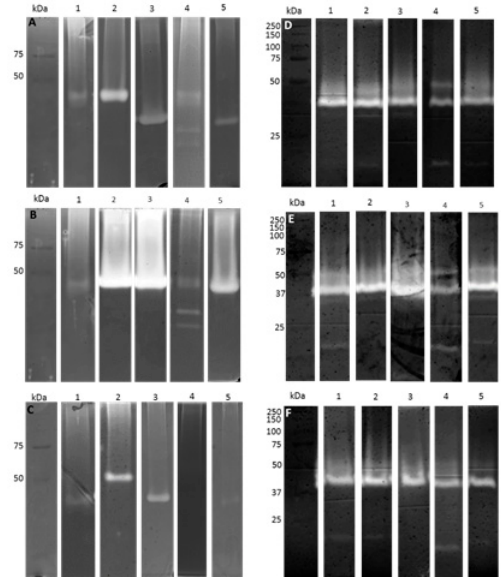
Figure 4. Extracellular gelatinolytic ( A – C ) and endoglucanolytic ( D – F ) activities of 5 strains of L. theobromae grown at 25 °C ( A / D ), 30 °C ( B / E ) and 37 °C ( C / F ). 1- LAMA-1, 2- CBS339.90, 3- LA-SV1, 4- CAA019, 5- LA-SOL3. Each gel is representative of three independent runs.